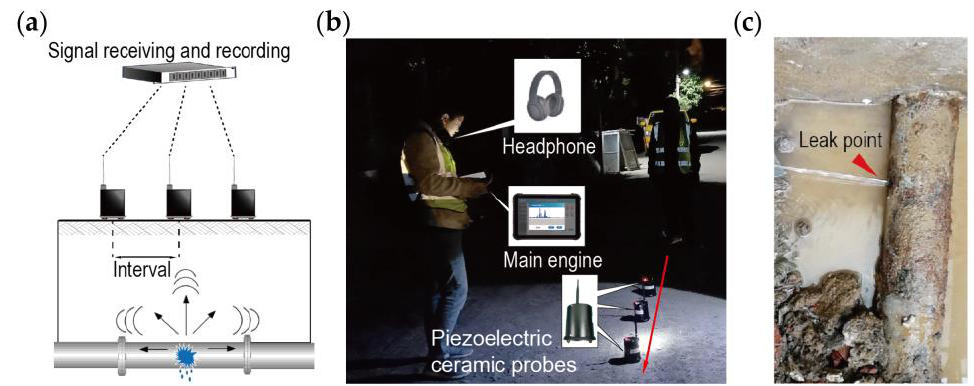
Figure 4. In situ signals’ acquisition on the ground in WDS: ( a ) Schematic diagram of the leak signal collection by electronic listening devices; ( b ) Site photo of the signal collection above a cast iron pipe with a leak. Piezoelectric ceramic probes of PQWT-LDC are used for signal collection. The direction of the pipeline is indicated by the red line with the arrow; ( c ) Leak hole of the cast iron pipe after excavation.